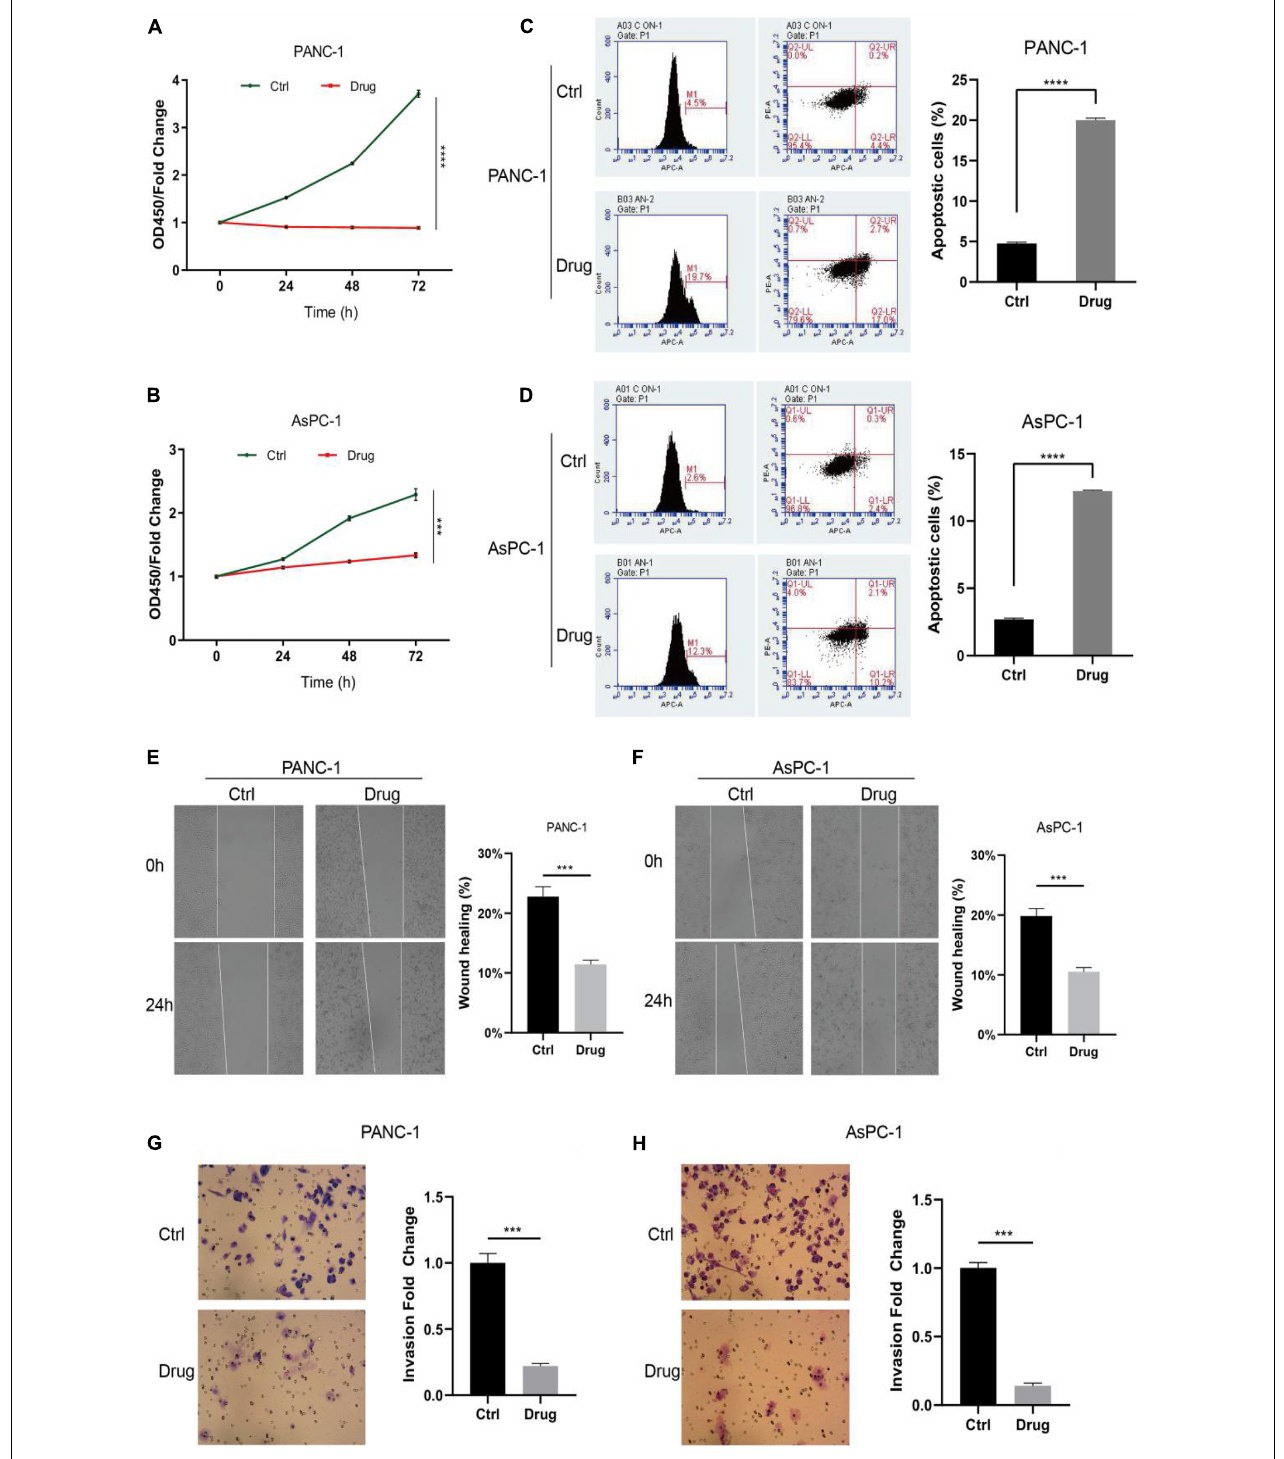
FIGURE 1 | Anlotinib was cytotoxic to pancreatic cancer cells. (A,B) CCK-8 assay of PANC-1 (A) or AsPC-1 (B) cells treated with anlotinib or DMSO. (C,D) Apoptosis assay of PANC-1 (C) or AsPC-1 (D) cells treated with anlotinib or DMSO. (E,F) Wound healing assay of PANC-1 (E) or AsPC-1 (F) cells treated with anlotinib or DMSO. (G,H) Invasion assay of PANC-1 (G) or AsPC-1 (H) cells treated with anlotinib or DMSO. Data were shown in mean ± SD and p < 0.05 was statistically significant. *** p < 0.001; **** p < 0.0001.